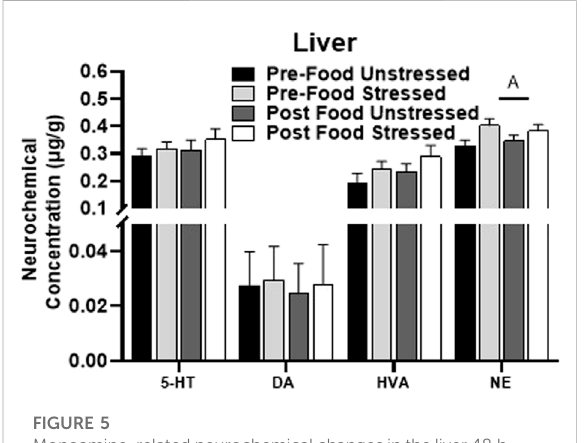
FIGURE 5 Monoamine-related neurochemical changes in the liver 48 h after stress exposure. Only a stress-induced increase NE concentrations was detected in the liver. ±S.E.M. signi fi cant main effect of stress (A) or food access (B) from Two-Way ANOVA. Signi fi cance p < 0.05. Sample size n = 9 per group, except Post Food Stress group n = 8.